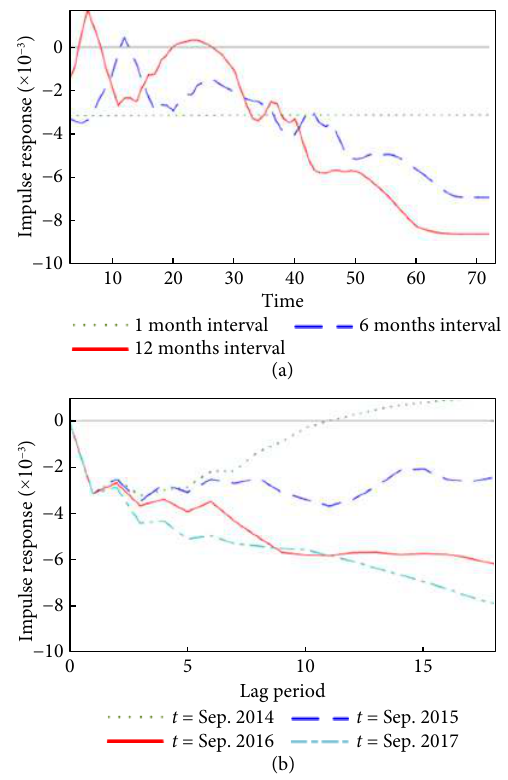
Fig. 6 Equidistant (a) and time-point (b) impulse responses of Index to